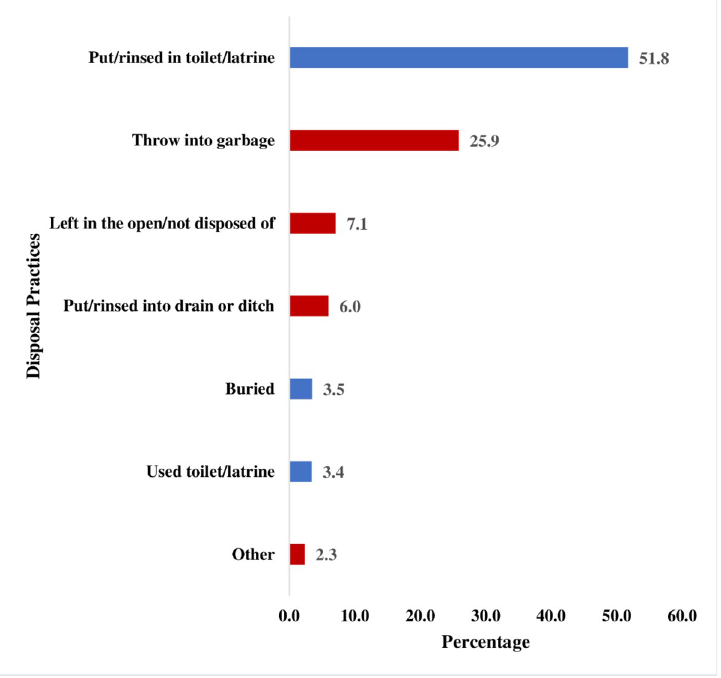
Fig 1. Prevalence of safe disposal of child stools by types of disposal in sub-Saharan Africa. Red: Unsafe, Blue: Safe. https://doi.org/10.1371/journal.pone.0254774.g001 PLOS ONE | https://doi.org/10.1371/journal.pone.0254774 August 2,